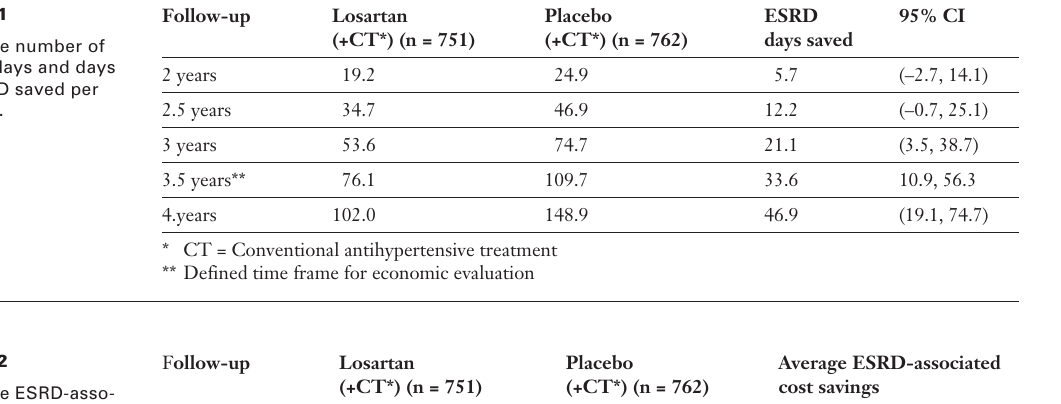
Average ESRD-asso- ciated costs and ESRD-associated cost savings per patient (CHF).